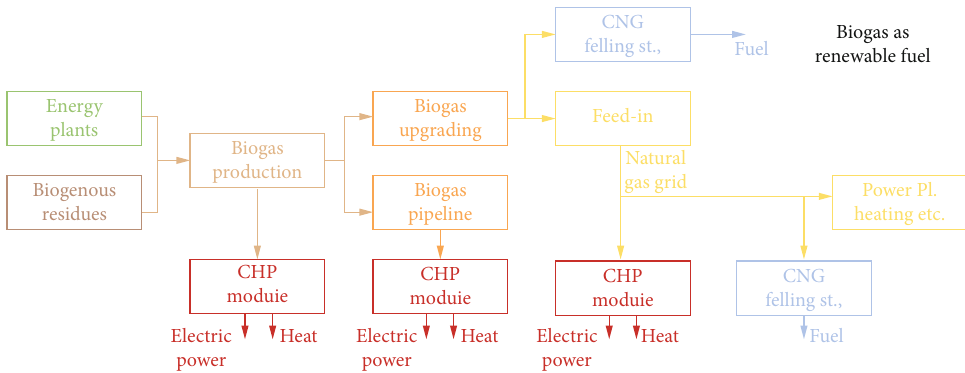
Figure 9: Biogas cogeneration systems and con fi gurations